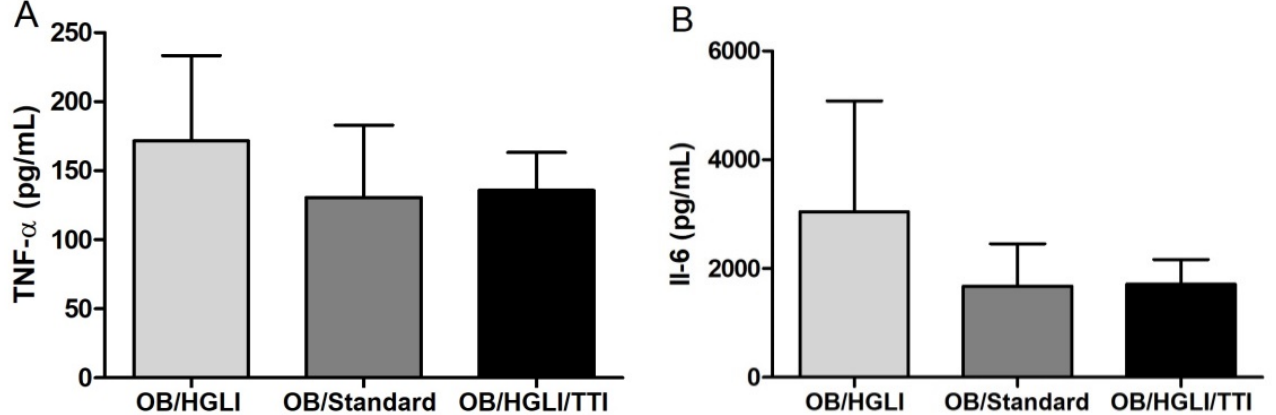
Figure 9. Inflammatory cytokine concentrations in small intestine homogenates of Wistar rats with obesity induced by HGLI diet, after ten days of the experiment. ( A ) Mean concentration of TNF ‐α in small intestine homogenates of animals in the groups: without treatment (OB/HGLI), treated with